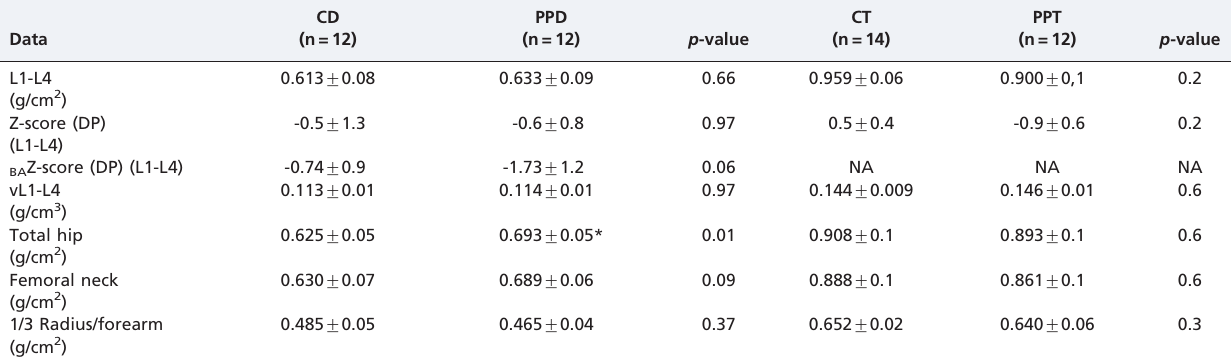
Table 4 - Bone mineral density assessment of control groups (CD and CT) and of patients with idiopathic central precocious puberty (iCPP) at diagnosis (PPD) and after treatment (PPT) with GnRHa.